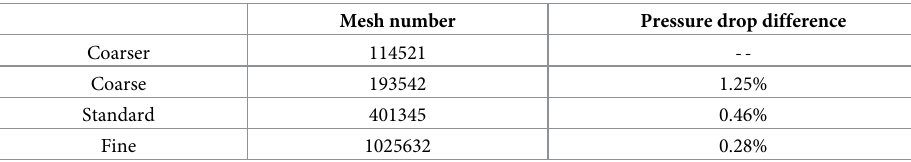
Table 1. Mesh size independence test.